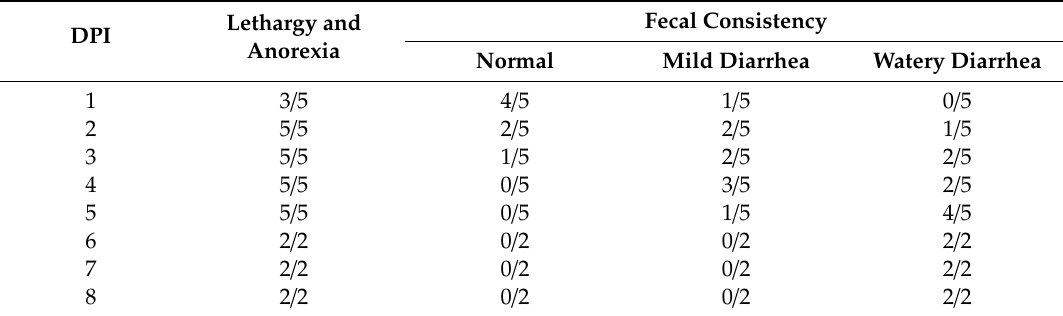
Table 4. Clinical observations of challenged piglets.